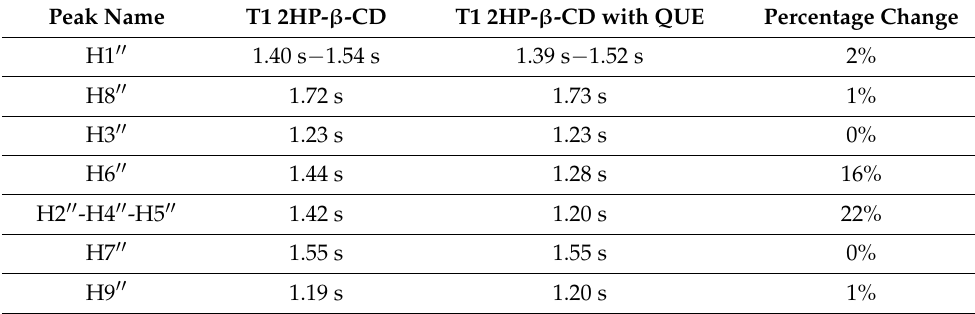
Table 6. T1 measurement for 2HP-CD before and after complexation.